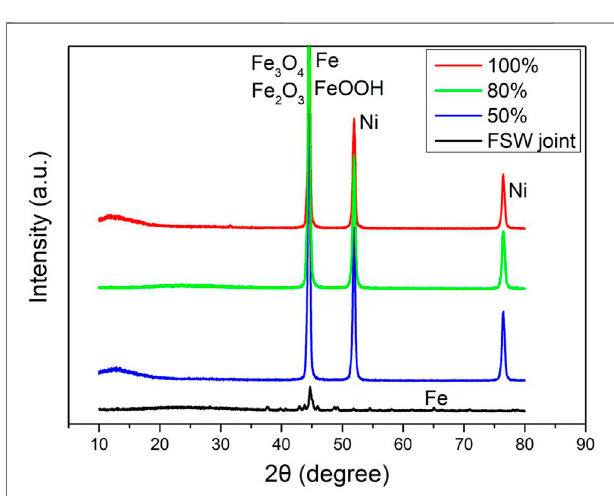
FIGURE 15 | XRD analysis of the samples after immersion in simulated seawater for 24